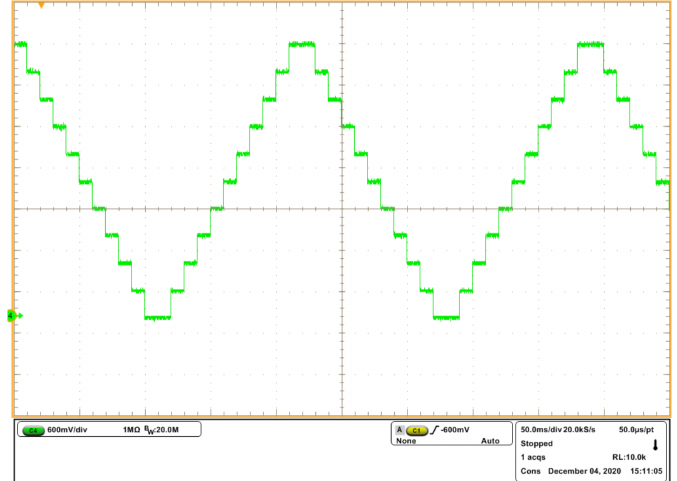
Figure 31. The input voltage signal generated by the waveform generator.